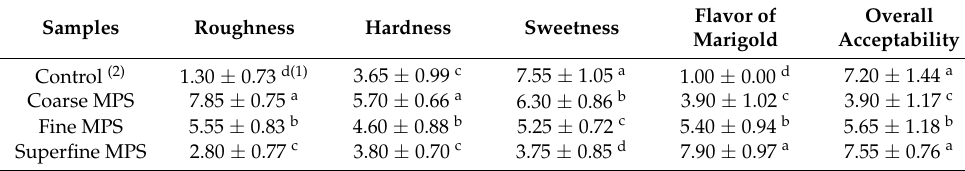
Table 5. Sensory evaluation of sponge cake prepared with differently sized MP.